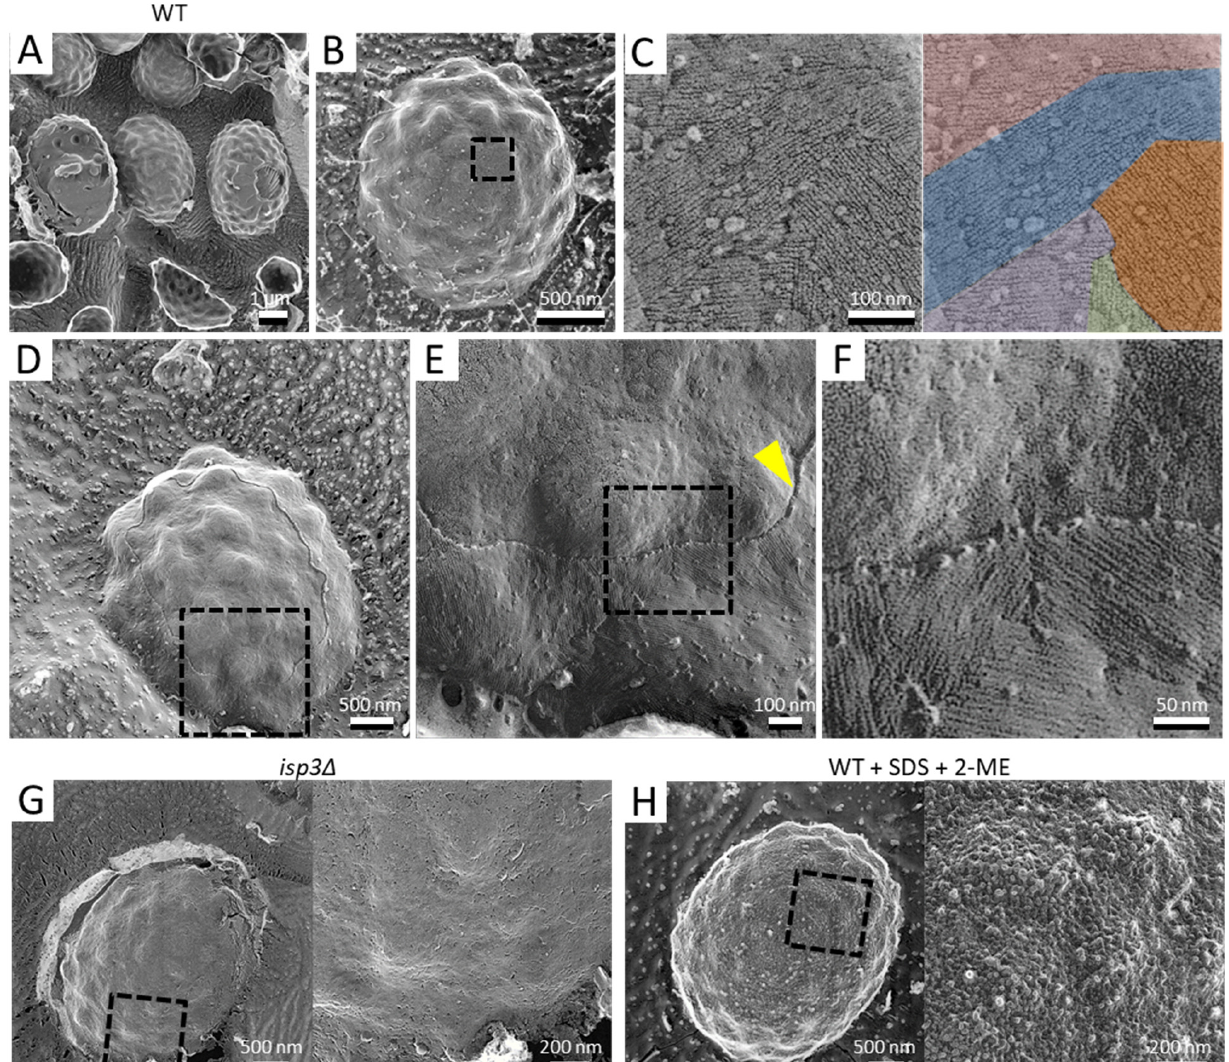
Figure 1. Surface structure of the S. pombe spore. (A) Field image of wild-type spores. Left spore shows a cytoplasmic cross-section. Center spore shows partial detachment of the surface layer. Right spore shows partial detachment of the spore wall. (B) Single spore. (C) Left, Magnified image of the boxed region in B. Right, the fibrillar structures are shown in various colors. (D) Spore with the outermost layer partly removed by fracture. (E) Magnified image of the boxed region in D. Arrowhead indicates a cross-section of the fractured surface layer. (F) Magnified image of the boxed region in E. (G) Left, isp3 Δ spore. Right, magnified image of the boxed region. (H) Left, wild-type spore pretreated with 1% SDS and 5% β -mercaptoethanol (2-ME). Right, magnified image of the boxed region.